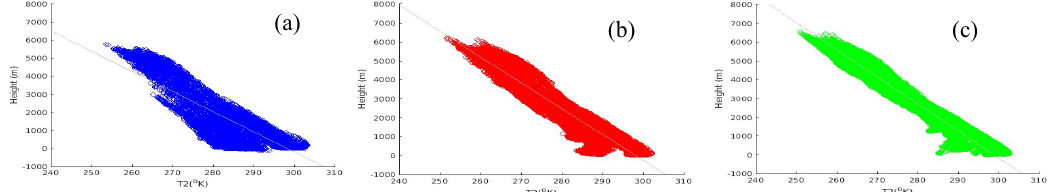
Figure 4. Lapse rate between T2 (Kelvin) and height (m) in d01 ( a ), d02 ( b ), and d03 ( c ).